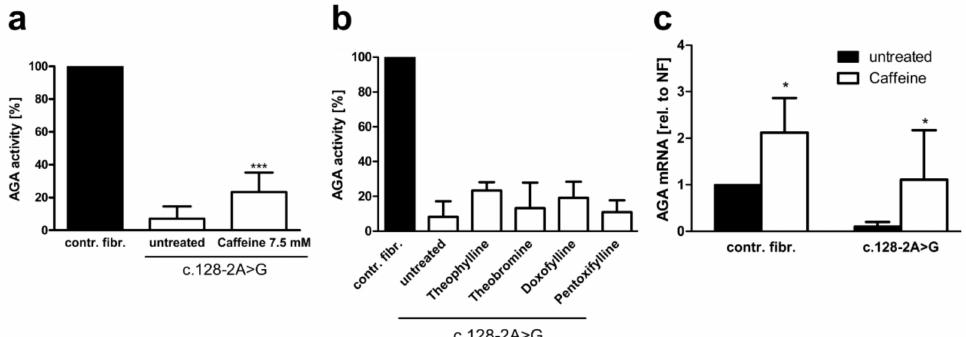
Figure 8. Effect of xanthine derivatives on the AGA activity and AGA mRNA level in AGU fibroblasts. Patient fibroblasts were treated for 48 h with 7.5 mM caffeine ( a ) or other methylxanthines ( b ), and the AGA activity was measured; n = 4, graphs show the mean ± SD. Statistical analysis by one-way ANOVA. ( c ) Patient and control fibroblasts were treated with 7.5 mM caffeine for 24 h. AGA transcript level was measured with qPCR using primers for exons 2 and 3, n = 6, two-way ANOVA. Values of p < 0.05 were considered significant (*)and p < 0.001 extremely significant (***).